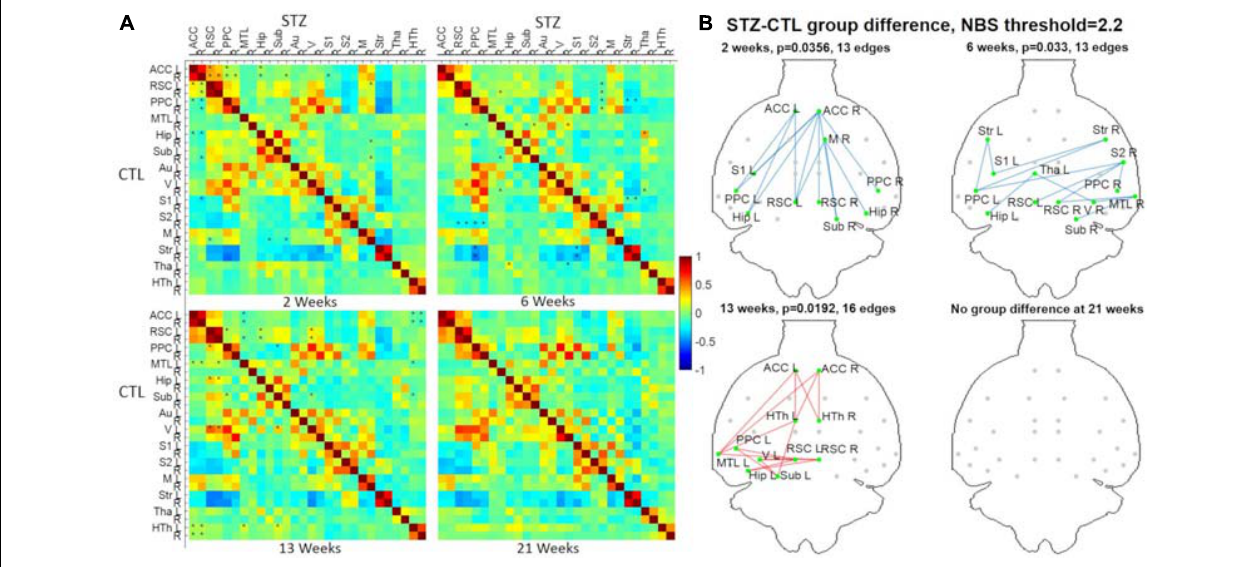
FIGURE 9 | (A) Hybrid average FC matrices at each timepoint (top-right half: STZ, bottom-left half: CTL) based on the data of Cohort 1 processed by the optimized pipeline G. ∗ : p < 0.05 (FWER corrected) at threshold of 2.2. (B) Graph networks at four timepoints. Blue/red edges and green nodes indicate connections with significant difference. The p -value for each network was given after FWER correction. ACC, anterior cingulate cortex; RSC, retrosplenial cortex; PPC, posterior parietal cortex; MTL, medial temporal lobe; Hip, hippocampus; Sub, subiculum; Au, auditory; V, visual; S1/S2, primary/secondary somatosensory; M, motor; Str, striatum; Tha, thalamus; HTh, hypothalamus; L/R, left/right. Figure adapted from Tristão Pereira et al. (2021), NeuroImage 2021, with